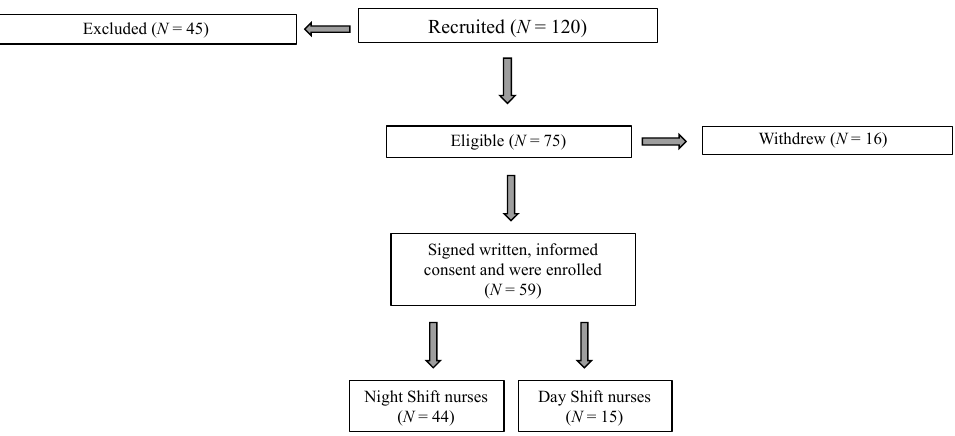
Figure 1. Participant recruitment. Study design, participant adherence, and dropout.